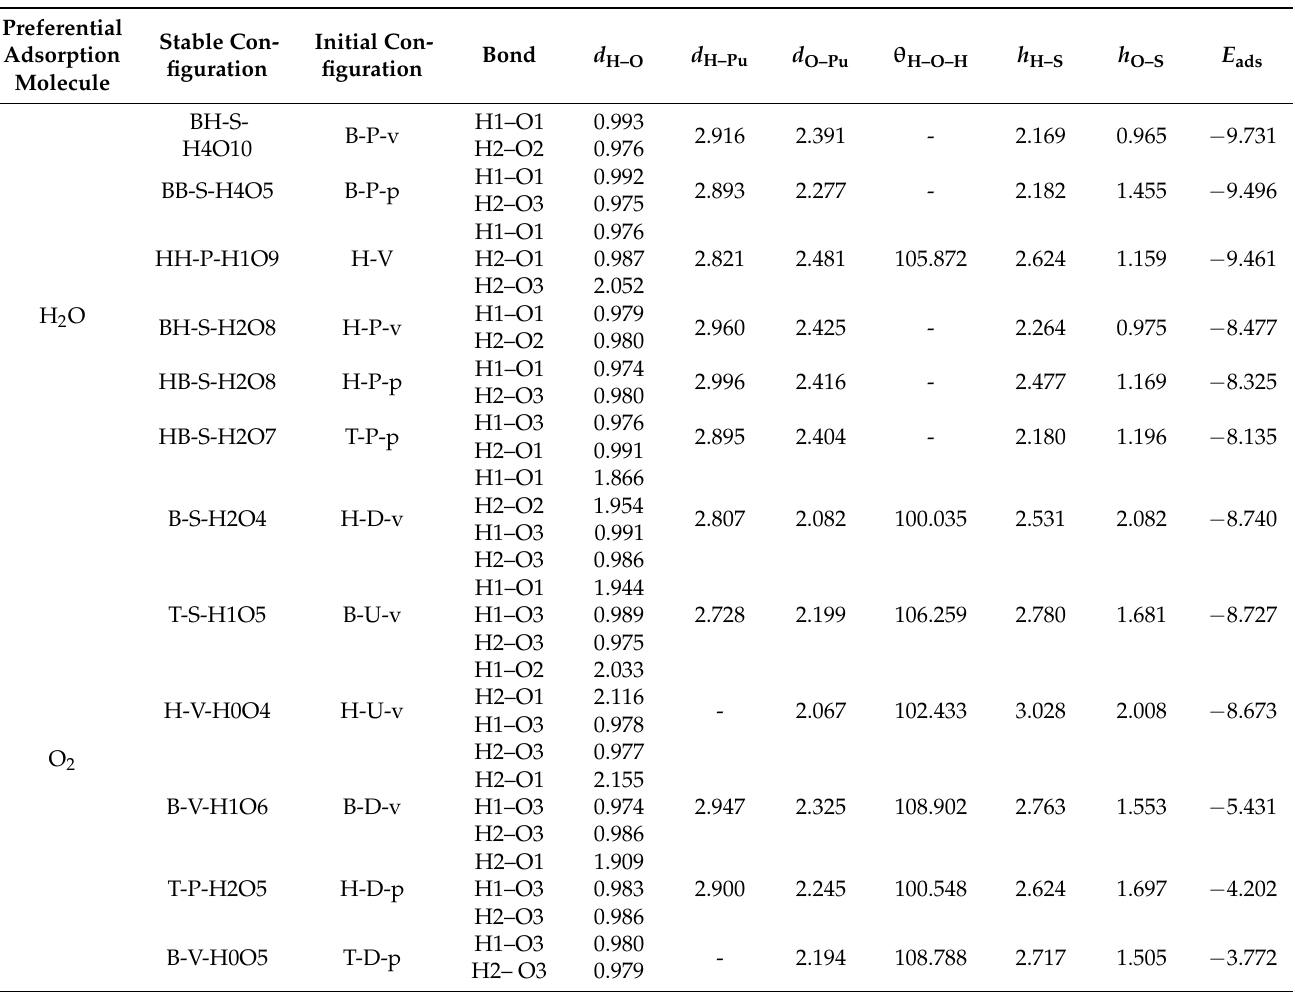
Table 1. Structural parameters and adsorption energy after co-adsorption of O 2 and H 2 O on δ -Pu (100)